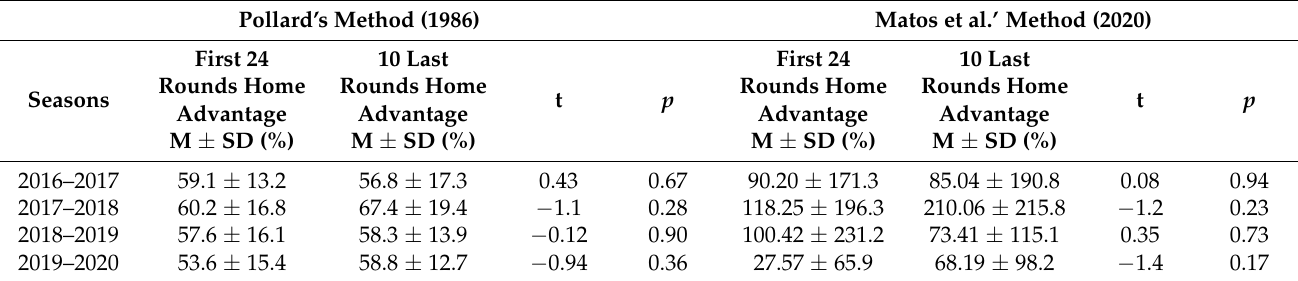
Table 1. Comparison of home advantage between first 24 rounds and last 10 rounds. Pollard’s Method